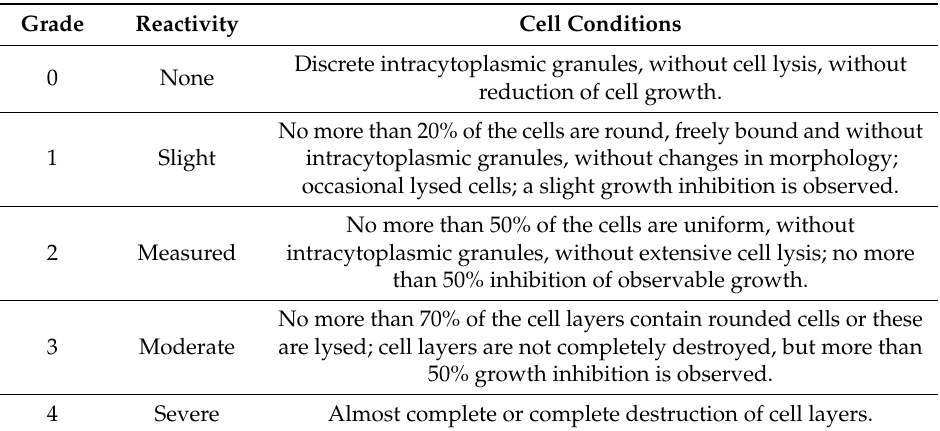
Table 2. Degree of reactivity according to cell